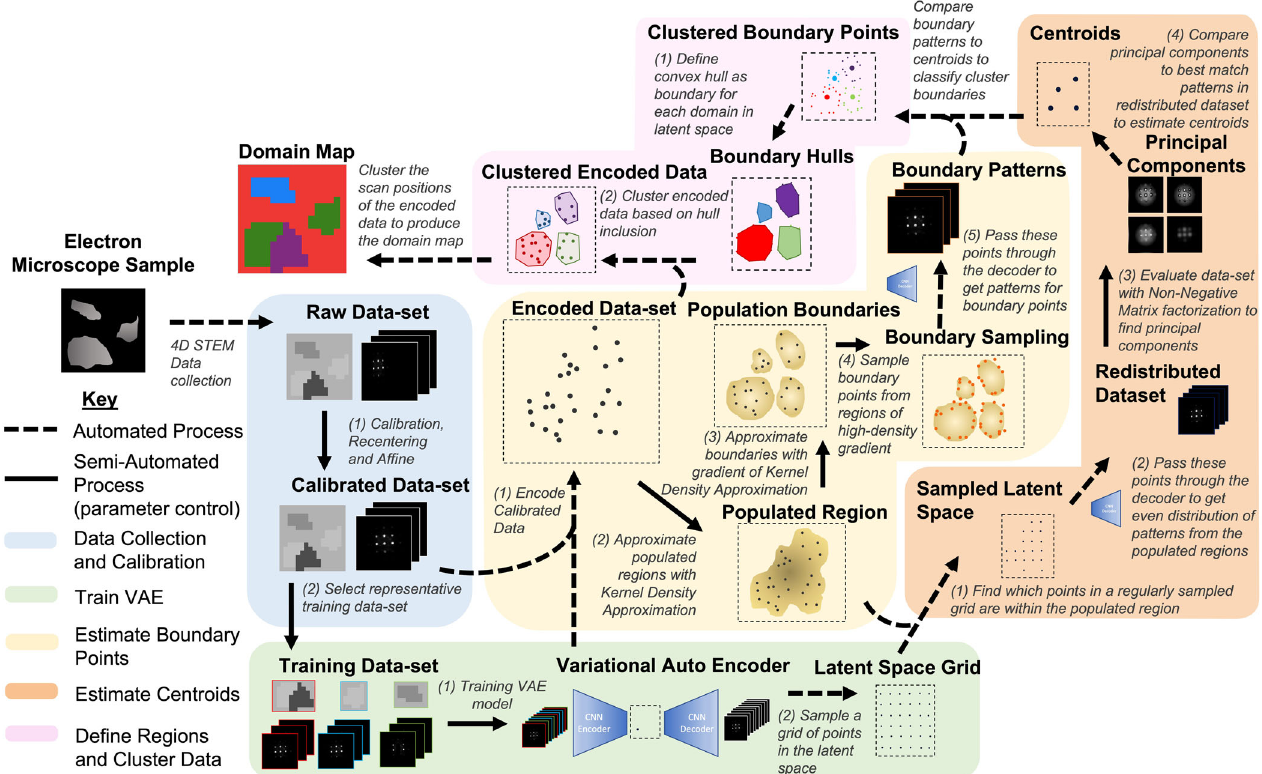
Fig. 1 Overview of proposed work fl ow. The motivation of each step can be most straightforwardly understood by working backwards from the fi nal domain